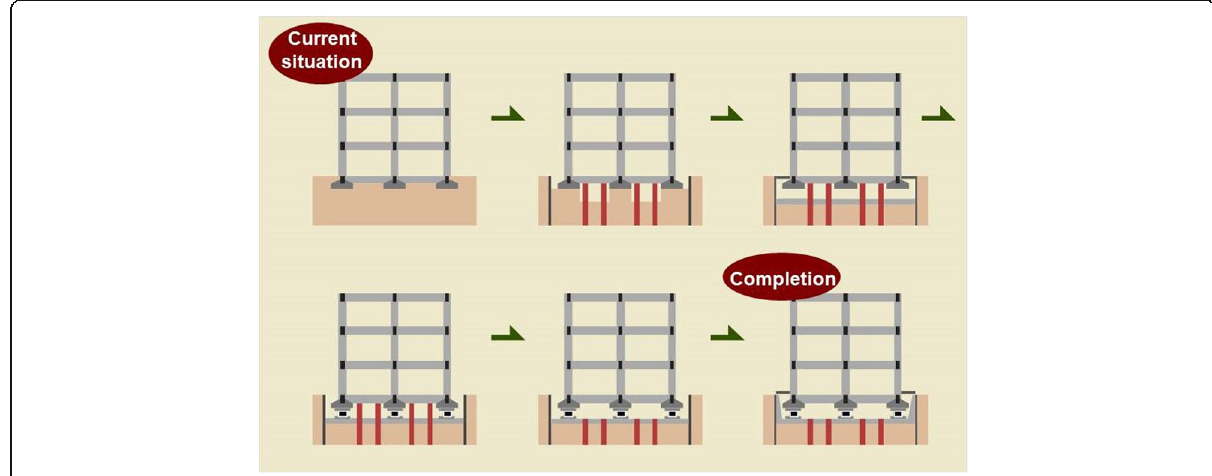
Fig. 14 Construction process of seismic isolation retrofit